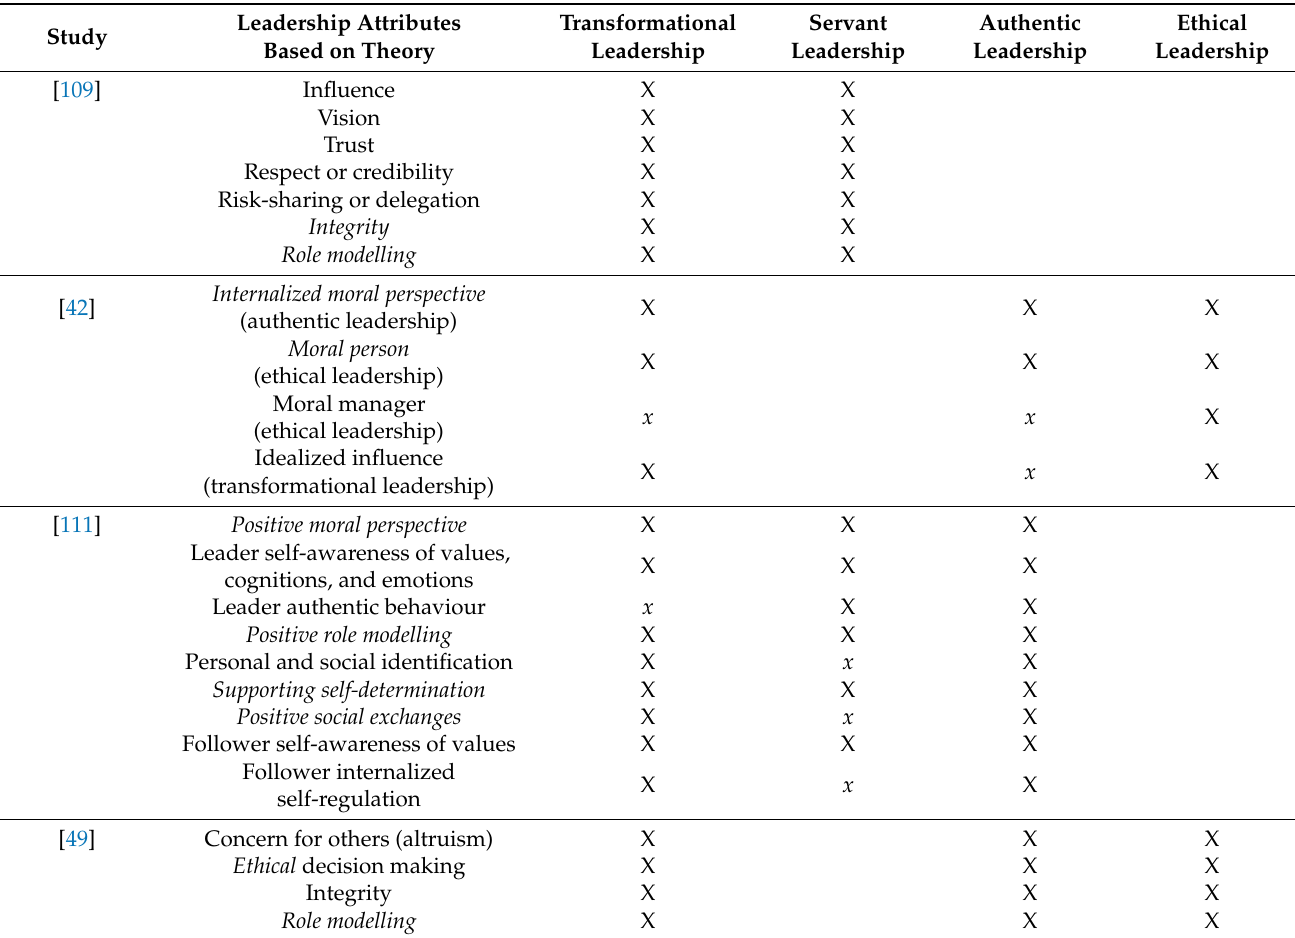
Table 3. Shared leadership attributes between different leadership styles based on theoretical